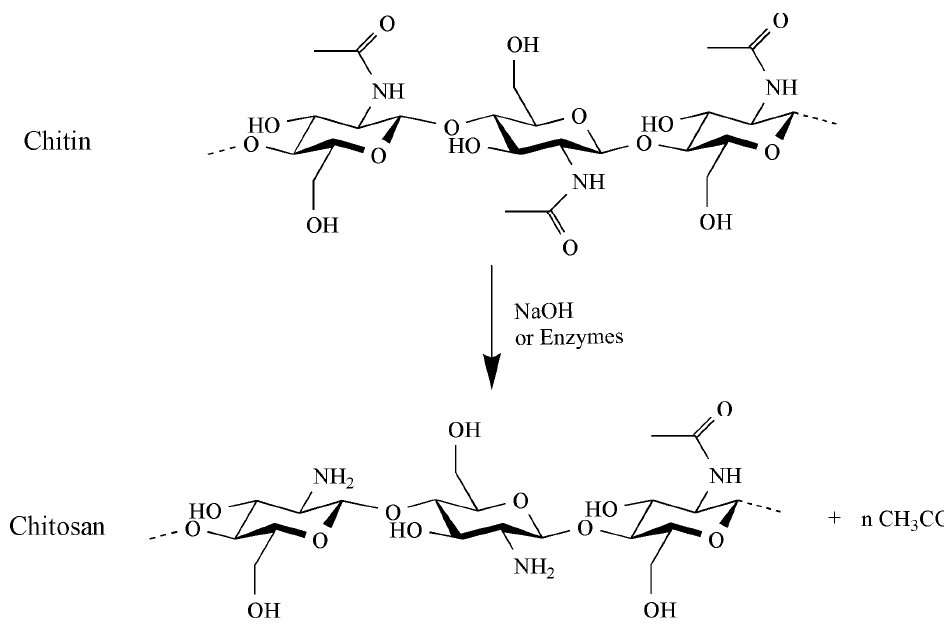
Figure 1. Chemical structure of chitin and chitosan. Chitosan is obtained through deacetylation of chitin using NaOH or enzymes.